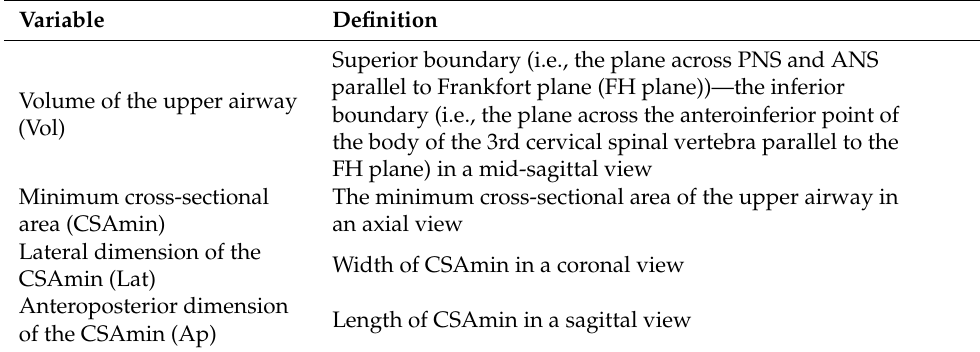
Table 2. Definitions of the upper airway measurements.